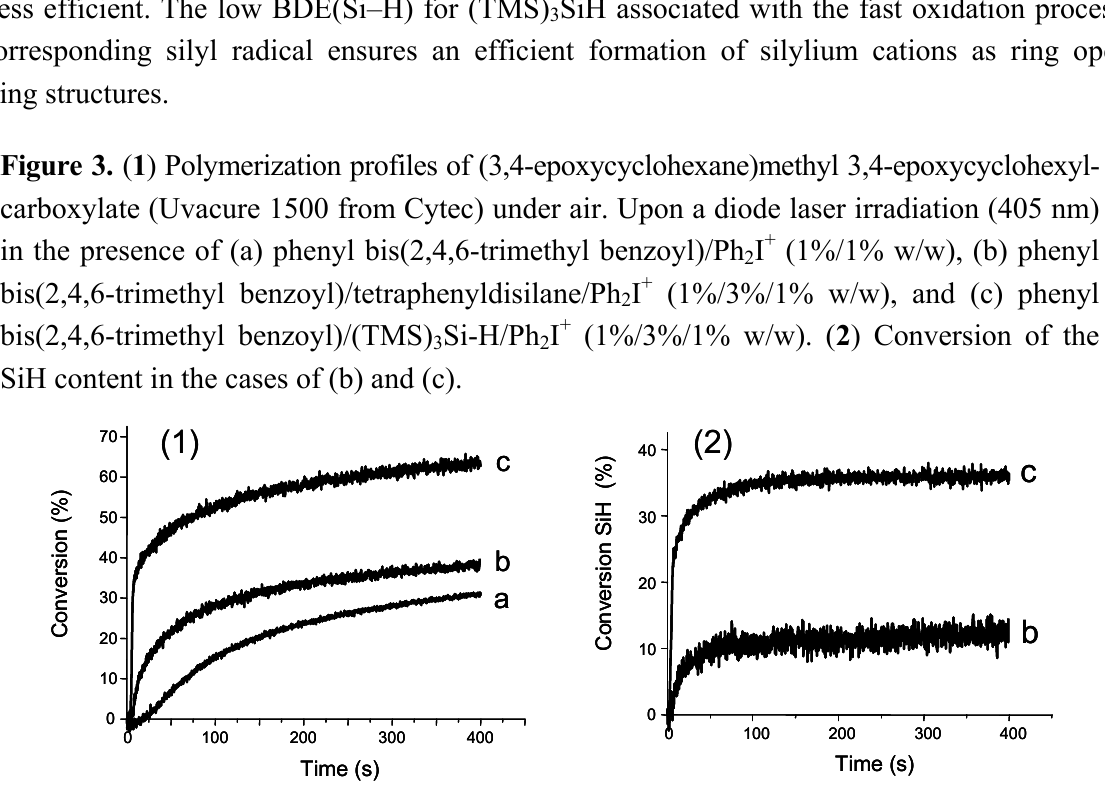
Figure 3. ( 1 ) Polymerization profiles of (3,4-epoxycyclohexane)methyl 3,4-epoxycyclohexyl- carboxylate (Uvacure 1500 from Cytec) under air. Upon a diode laser irradiation (405 nm) in the presence of (a) phenyl bis(2,4,6-trimethyl benzoyl)/Ph bis(2,4,6-trimethyl benzoyl)/tetraphenyldisilane/Ph bis(2,4,6-trimethyl benzoyl)/(TMS)